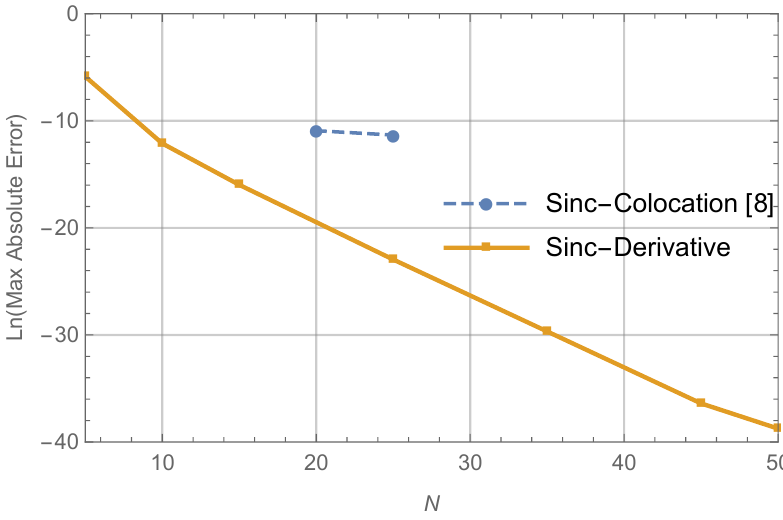
Figure 3. Log of the max absolute errors for the method used in [24] and the current sinc-drivative method as a function of the number of nodes ( N ) for Example 1